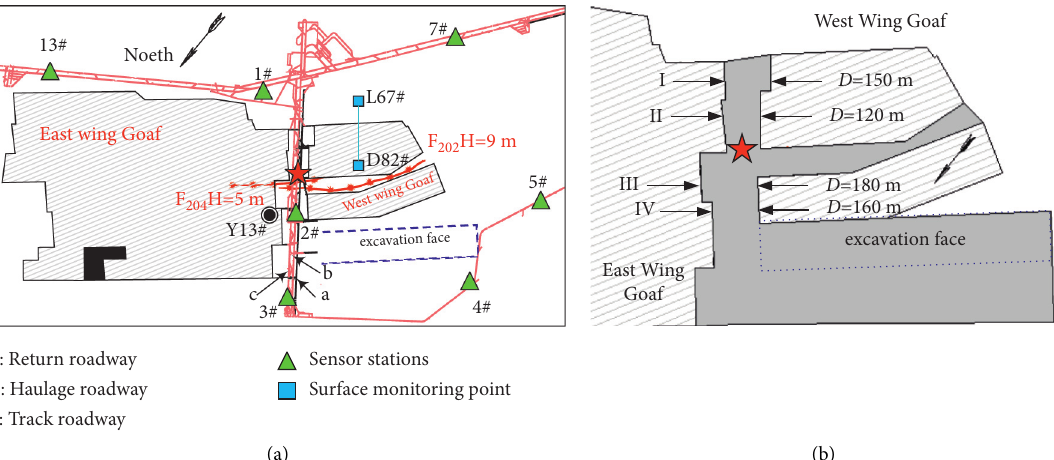
Figure 1: Central mining district district’s isolated asymmetric isolated coal pillar arrangement: (a) actual measurement layout; (b) sketch